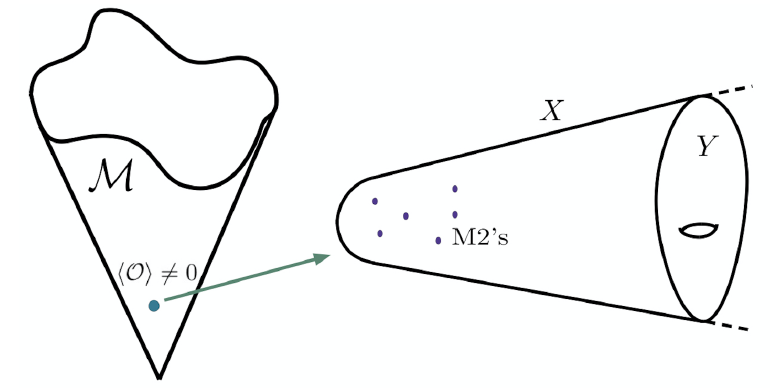
Figure 2 . Generic vacuum on the moduli space (on the left), which spontaneously breaks the conformal symmetry, and its dual asymptotically AdS geometry (on the